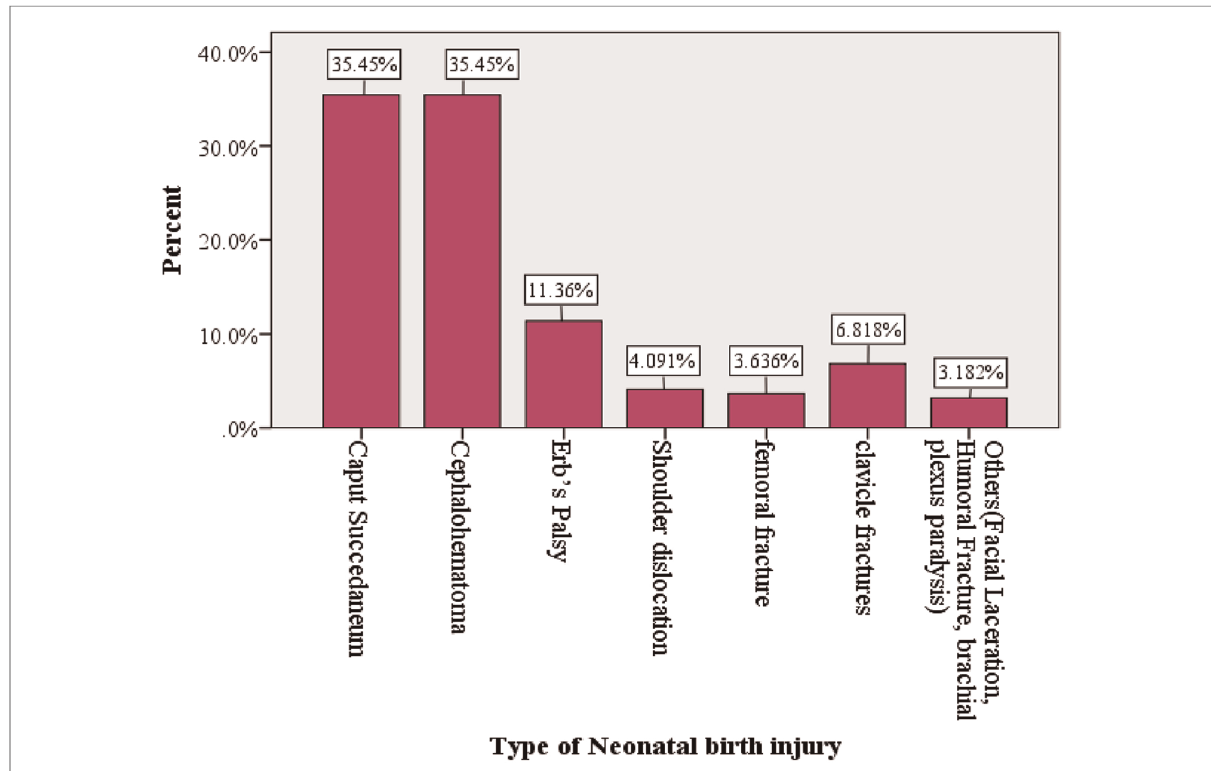
FIGURE 2 Type of neonatal birth injury among neonates admitted at NICU ward in government hospitals located in Southwest Ethiopian people regional state, Ethiopia,